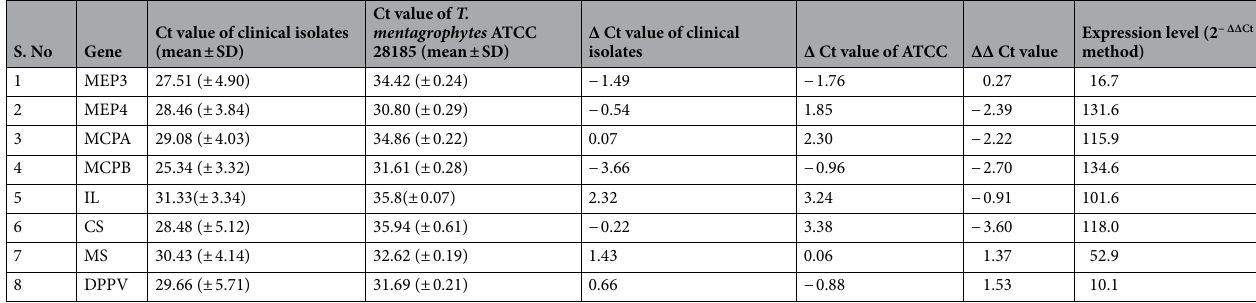
Table 1. Status of differential expression level of virulence genes of T. mentagrophytes.